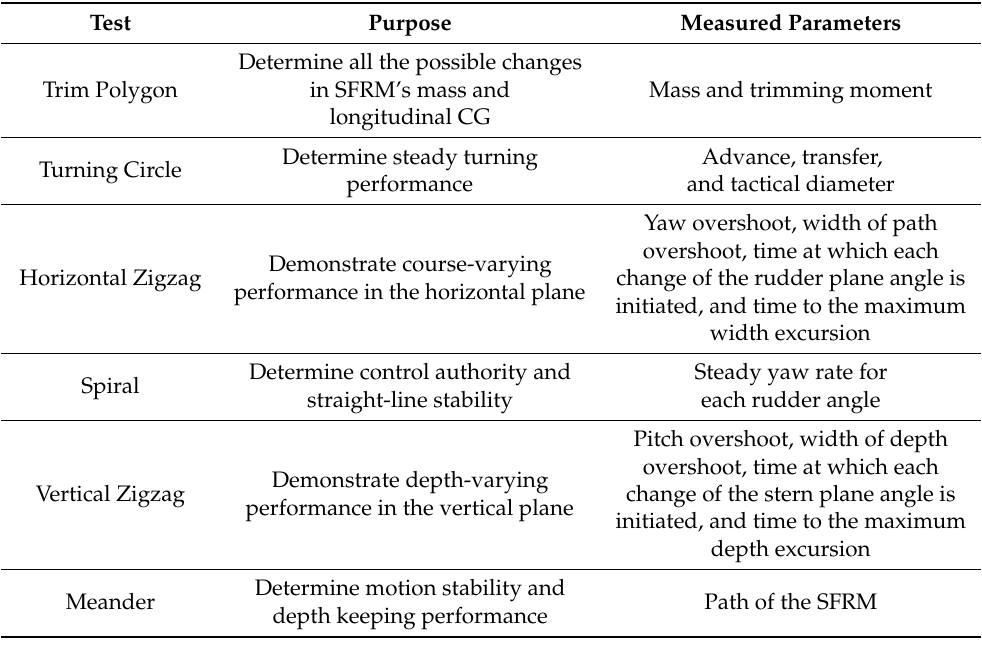
Table 4. Standard manoeuvring tests for the